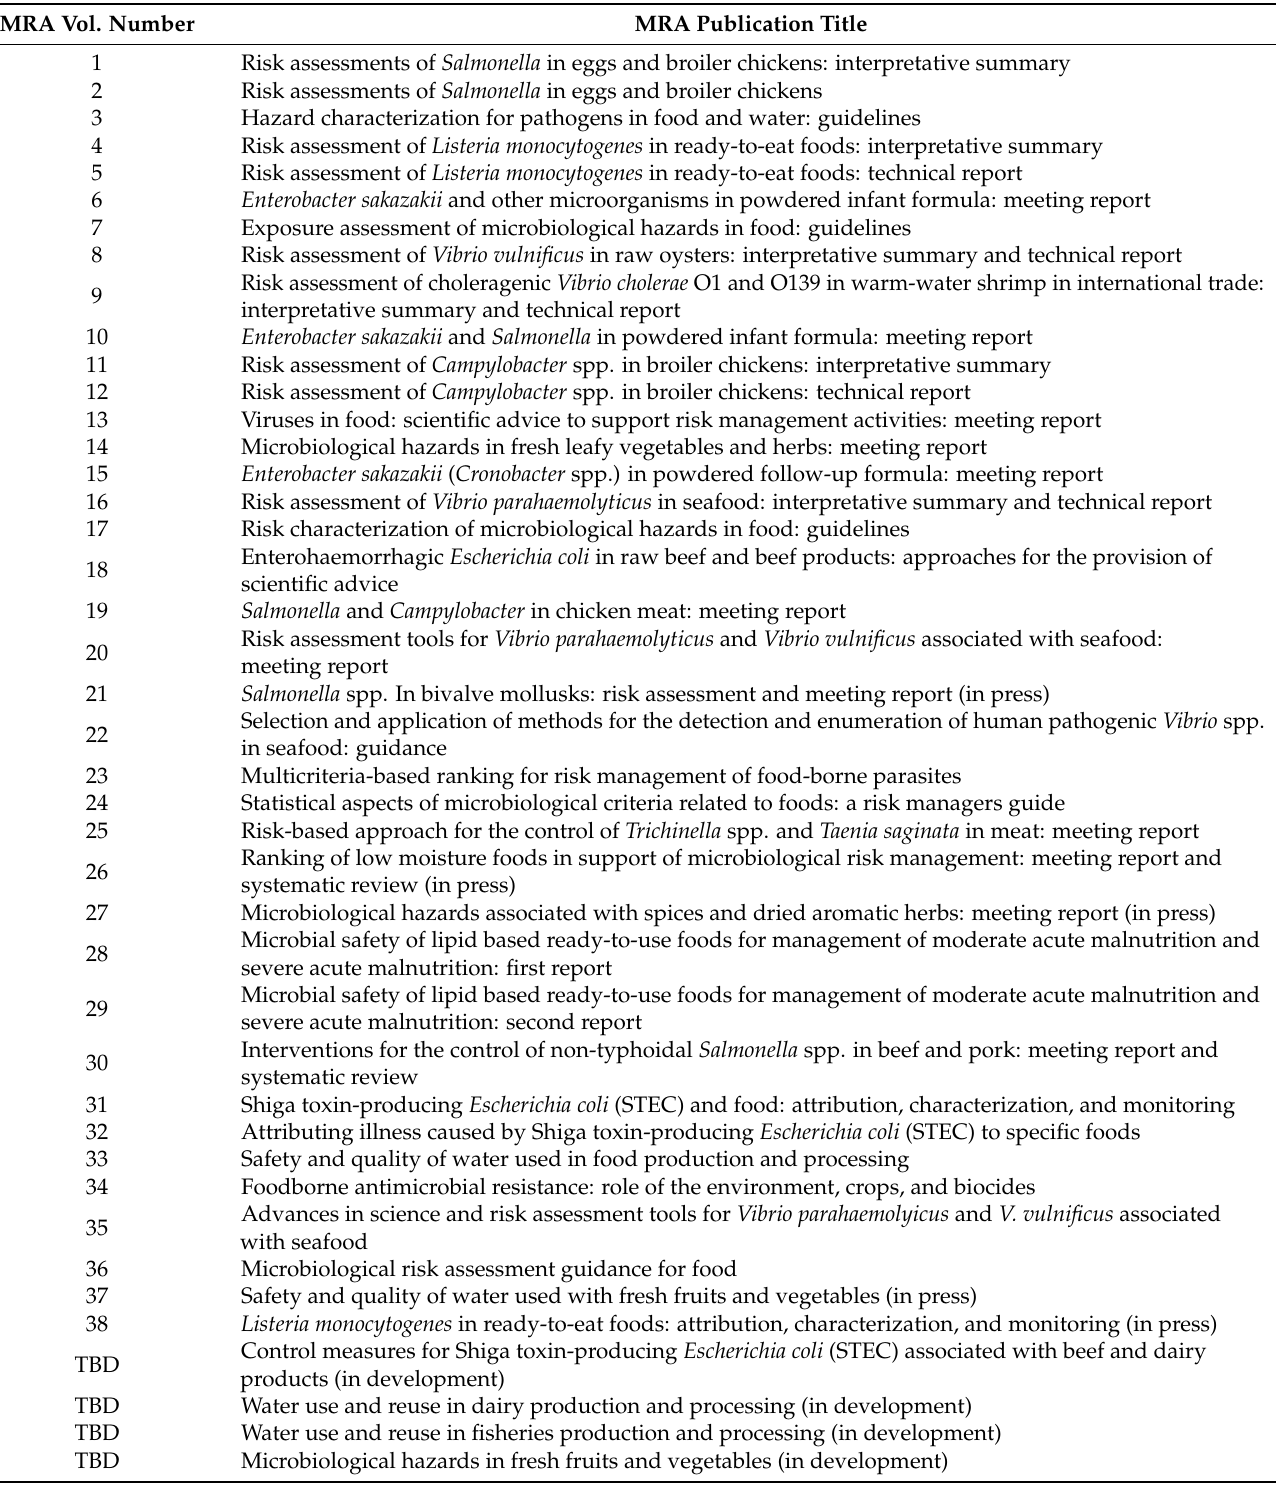
Table 1. List of publications in the FAO/WHO microbiological risk assessment (MRA) series. MRA Vol.